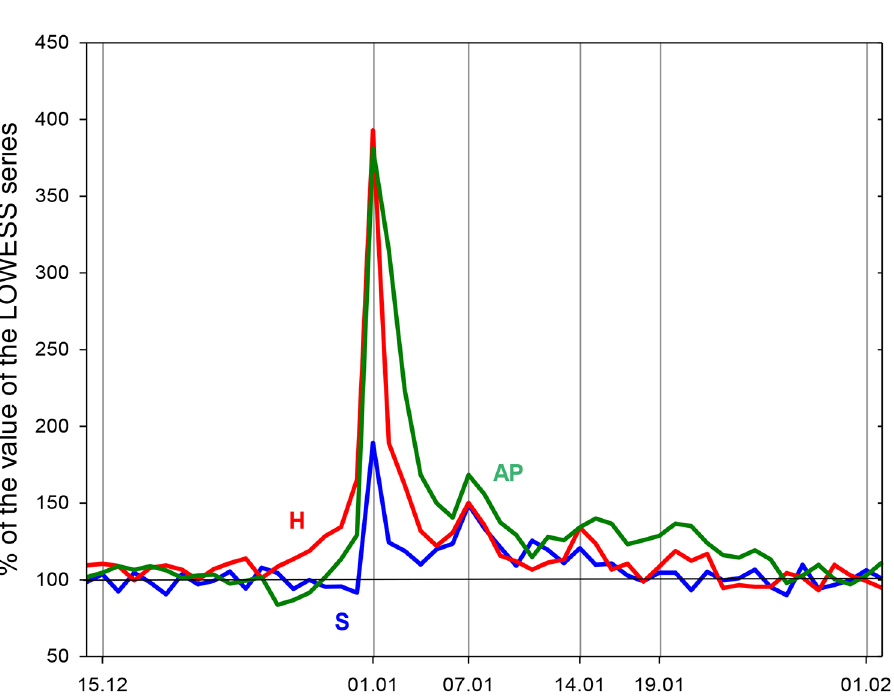
Fig. 5. Number of excess deaths in Russia from December 15 to February 1, the sum of indicators for 2011–2019, % of LOWESS moving average taken as 100%. Note: AP — alcohol poisoning, H — homicide, S — suicide. Source: authors’ calculations based on modelling and Rosstat